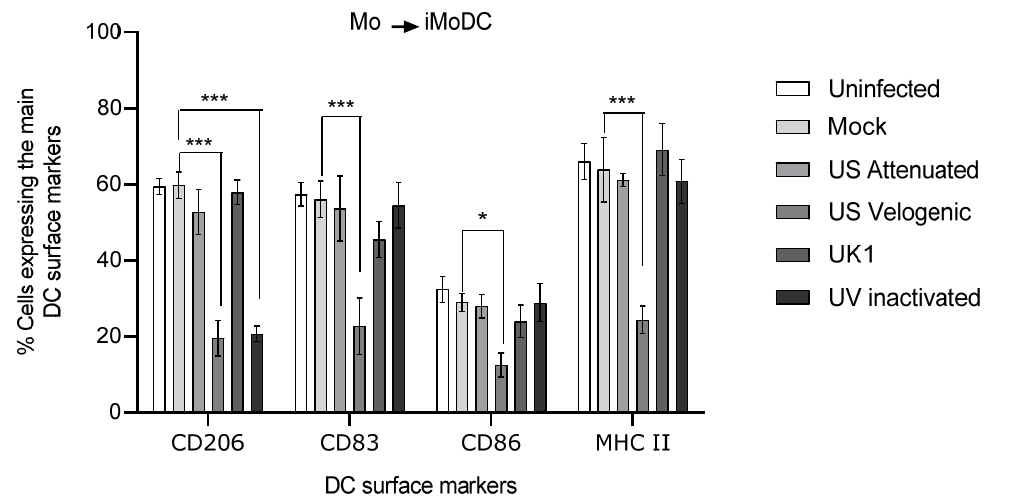
Figure 11. Effect of EAV infection on MoDC differentiation. Monocytes were inoculated at MOI of 5 with different strains of live and UV inactivated virus. Cells were incubated for 2 h after infection prior to the addition of 1000 U/mL of GM-CSF and 500 U/mL of IL-4. Cultures were incubated further for 16 h, after which cells were harvested and stained to assess phenotype by flow cytometry. For the different treatments, the same number of events (10,000) were analyzed in the target gate. There were significant differences during differentiation in the phenotype of MoDC infected with the Velogenic strain. Results were represented as the percentage surface marker expression ± SEM ( n = 6). A 2-way ANOVA with Bonferroni post-test was used to compare replicate means. * and *** indicate significant differences between sample means where p < 0.05 and 0.001.